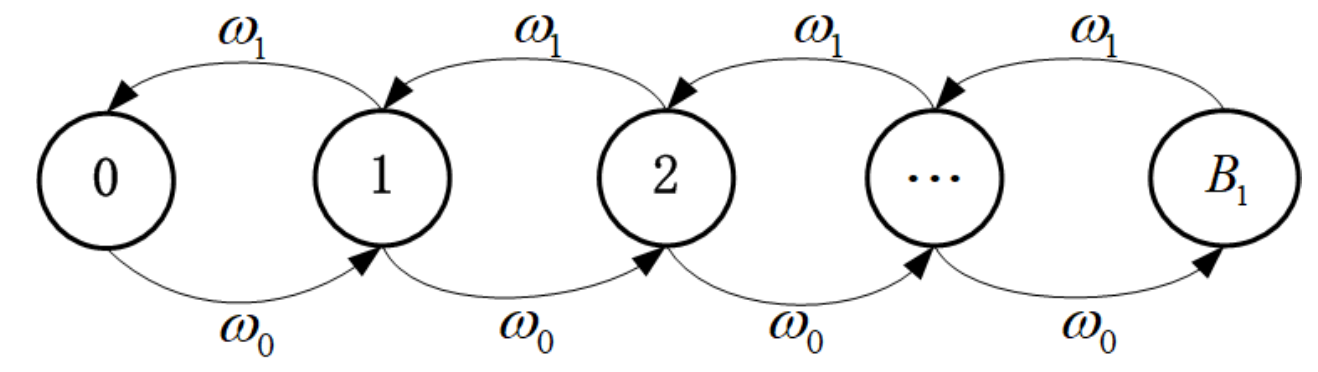
Figure 9. State-transition diagram of the buffer B 1 .